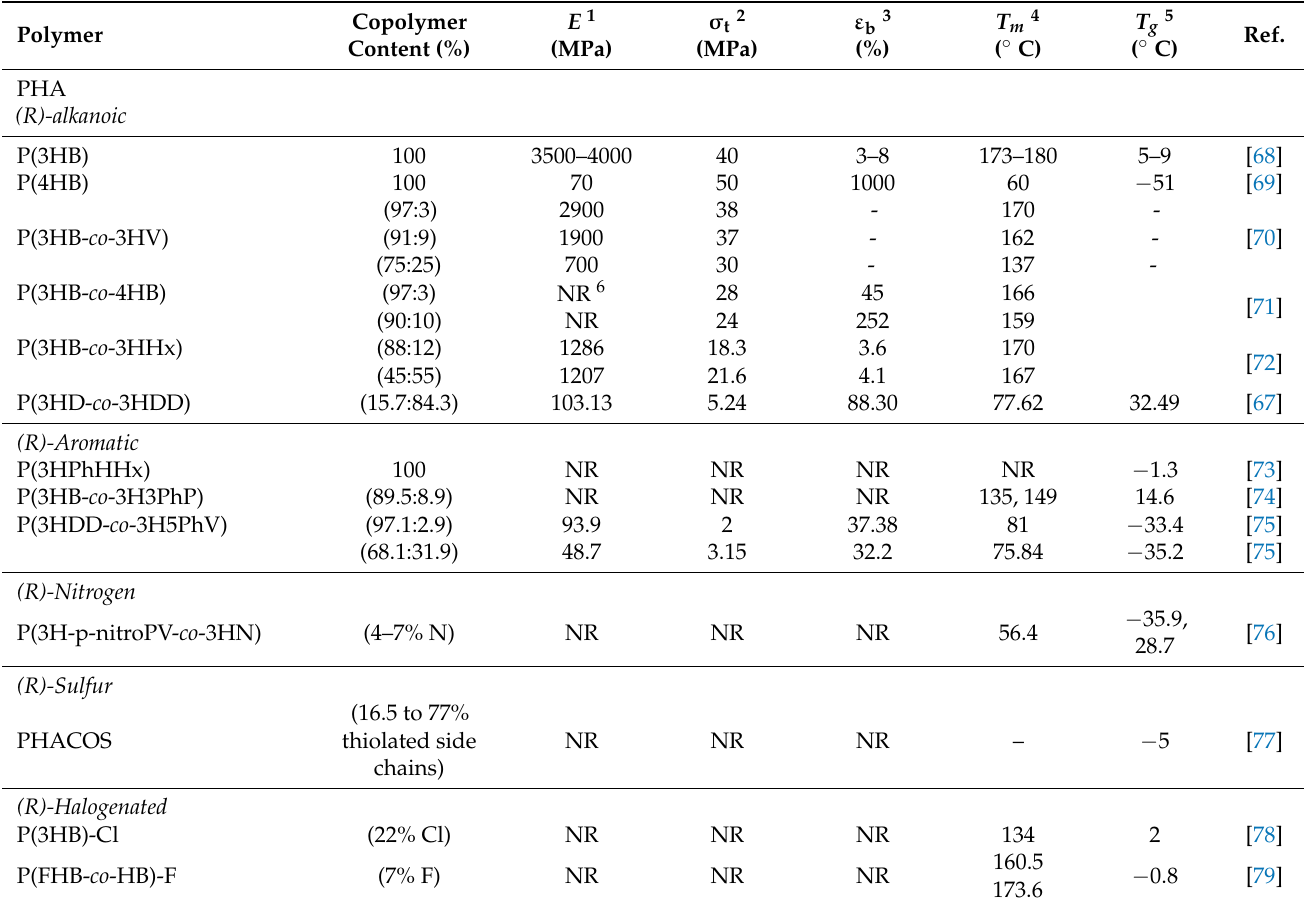
Table 3. Thermal and mechanical properties of some representative polymers from the PHA family.